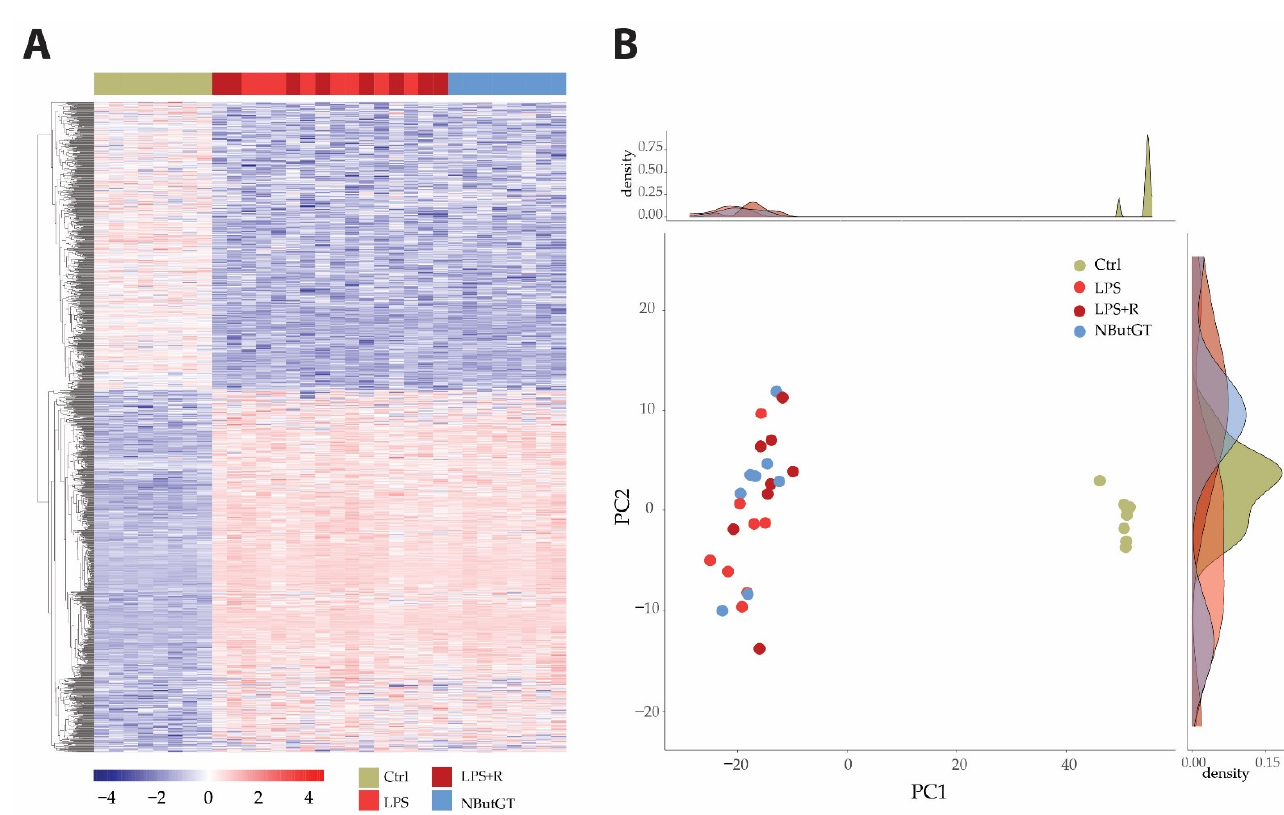
Figure 1. Impact of septic shock and NButGT on O-GlcNAcylation. Evaluation using Western blot of the O-GlcNAcylation levels ( A ), ncOGT ( B ), and lOGA ( C ) expression in the heart in CTRL, LPS, LPS + R and NButGT group. Statistical significance was assessed using a Kruskal – Wallis test with uncorrected Dunn’s post-test. Quantification was performed in relation to stain-free. Results are expressed as mean ± SEM. CTRL: control group; LPS: i.v. injection of LPS (20 mg/kg); LPS + R: s.c. administration of 10 mL/kg of NaCl 0.9%; NButGT: fluidotherapy supplemented with NButGT (10 mg/kg). n = 6–7. *: p < 0.05.